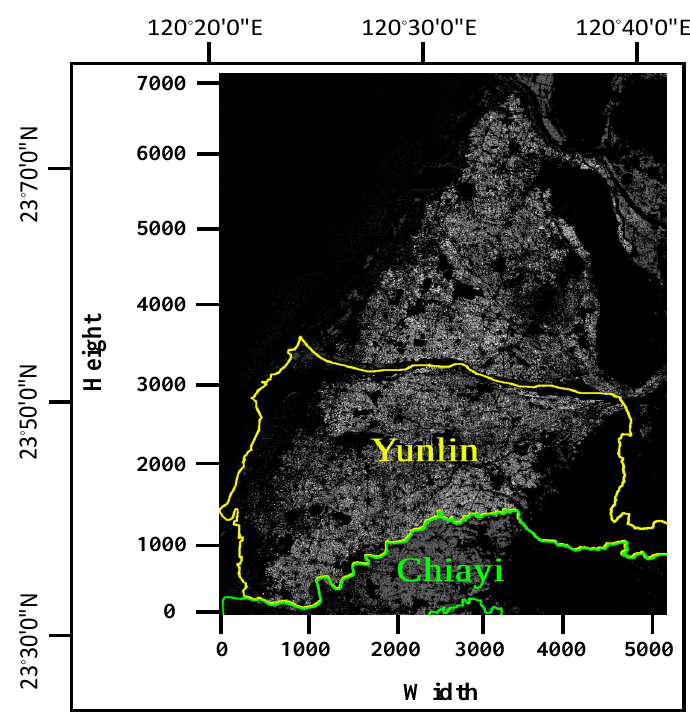
Figure 1. Yunlin and Chiayi counties’ data was received from Sentinel-1A in February 2017, where the height and width represent the number of pixels. White indicates the distribution of rice